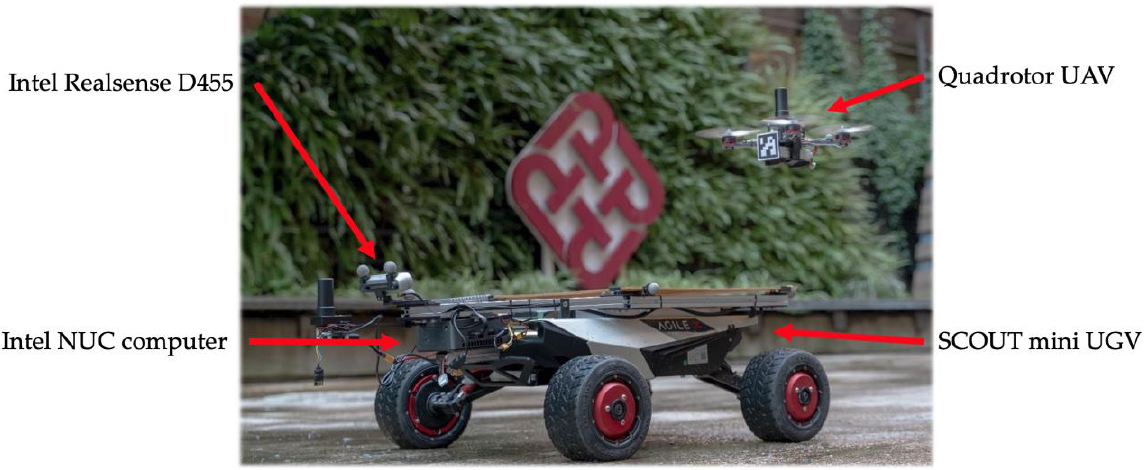
Figure 1. Prototype of the proactive guidance UGV and the UAV.